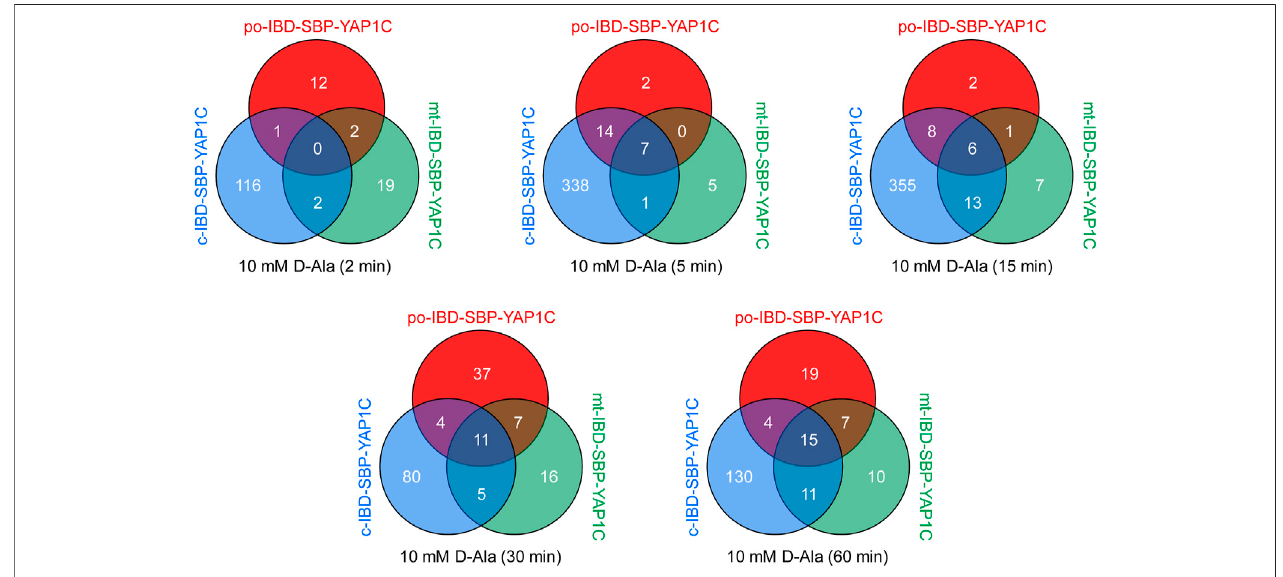
FIGURE4| Venndiagramsshowingthenumberandoverlapofpo-,c-,andmt-IBD-SBP-YAP1Cinteractorsatdifferenttimepointsafter treatment ofFlp-InT-REx 293 cells expressing po-DD-DAO with 10 mM D-Ala.